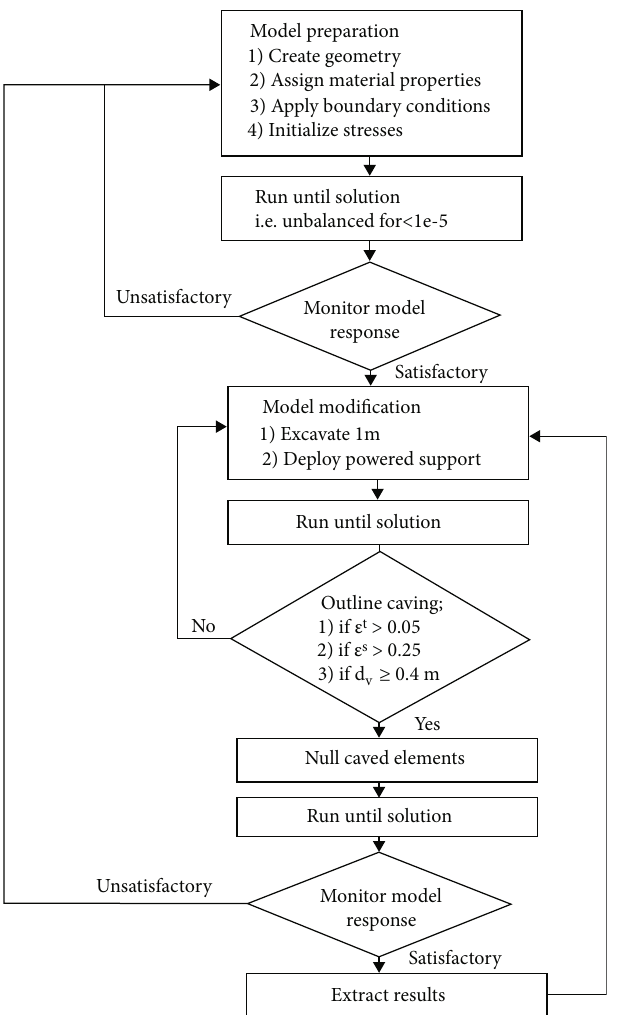
Figure 8: Algorithm for progressive coal extraction, deployment of powered support, and strata caving.